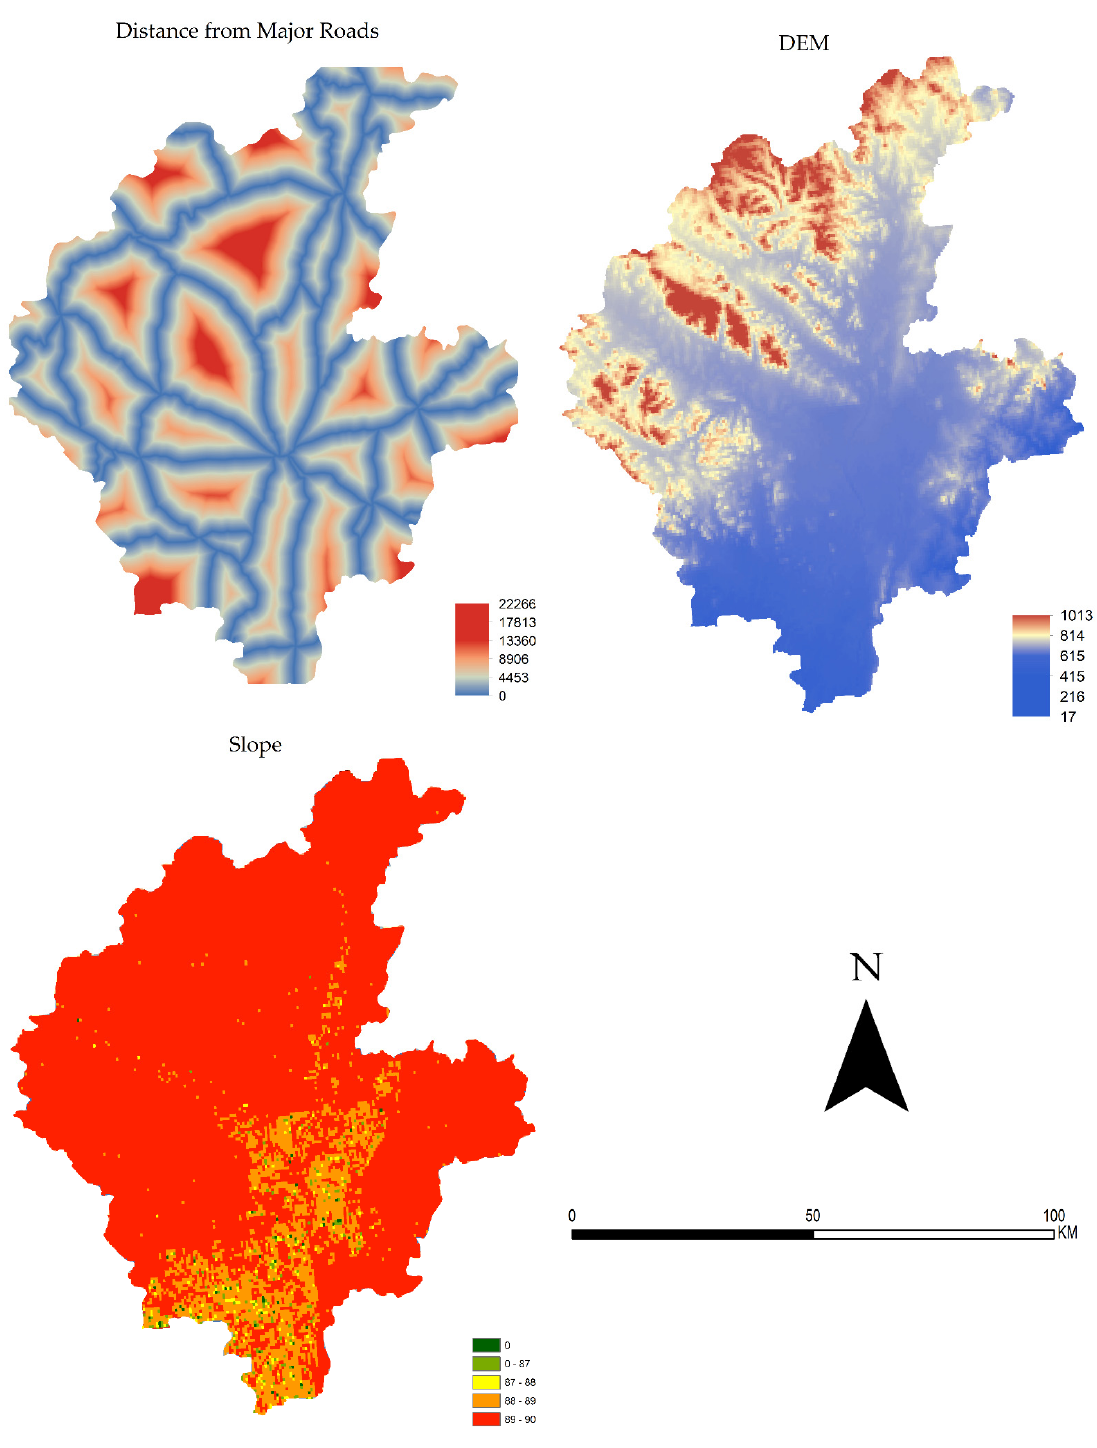
Figure 8. Spatial variables used in the study. Table 14. Cramer’s V value of spatial